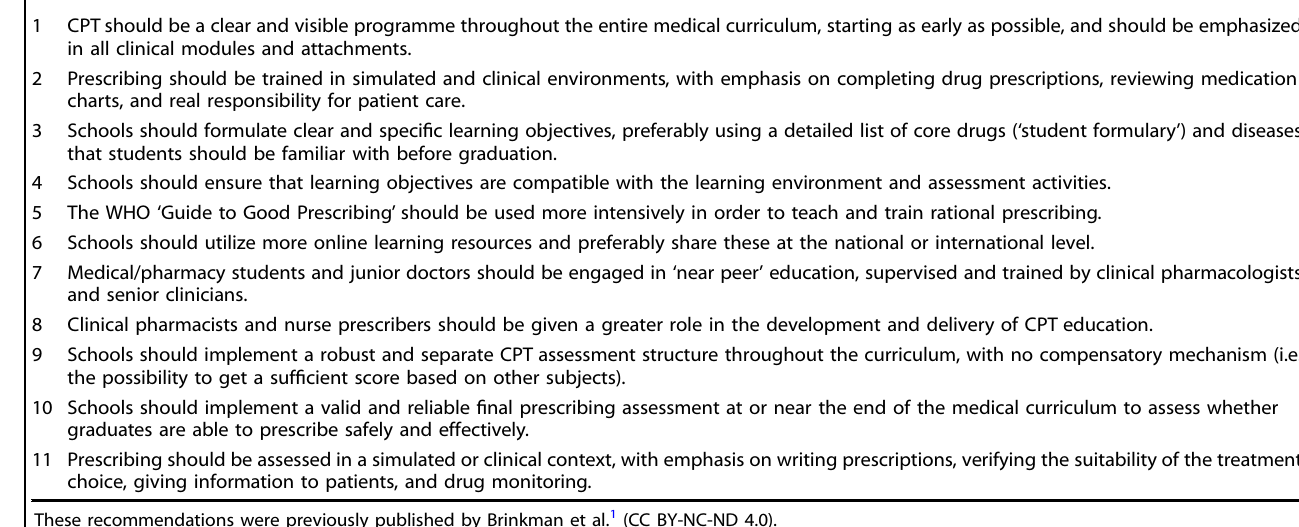
Table 1. Recommendations of the European Association for Clinical Pharmacology and Therapeutics Education Working Group to improve and harmonize clinical pharmacology and therapeutics (CPT)